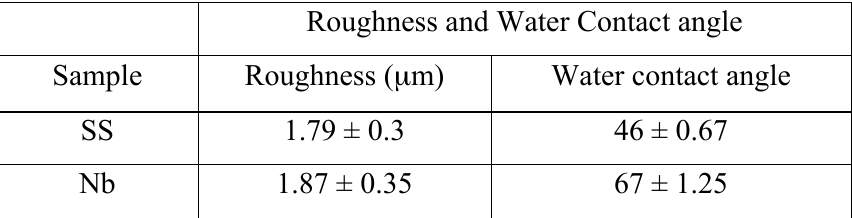
Table 1. Surface average roughness and water contact angles including the standard deviation error after 12 and 10 measurements,